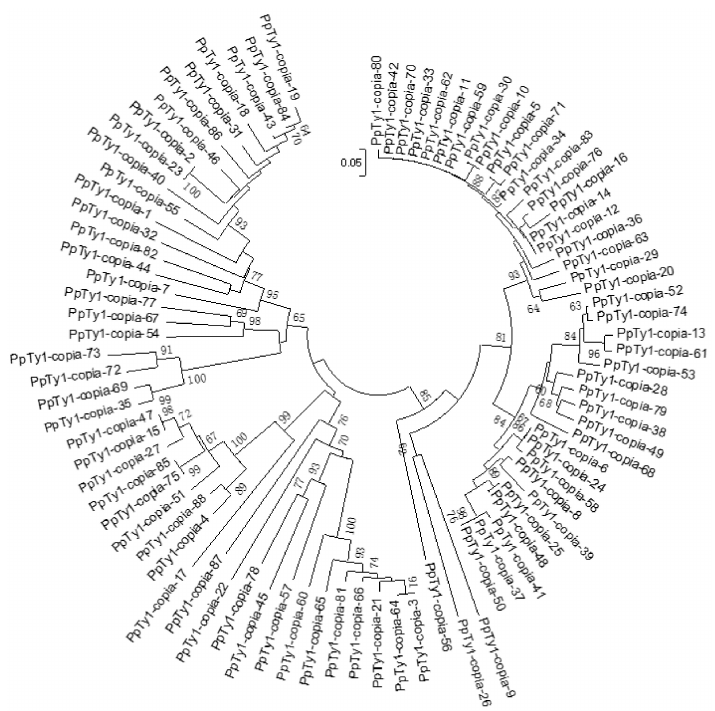
Figure 1. Phylogenetic analysis of Ty1- copia RT isolated from P. purpureum . The bootstrap support above 60% were